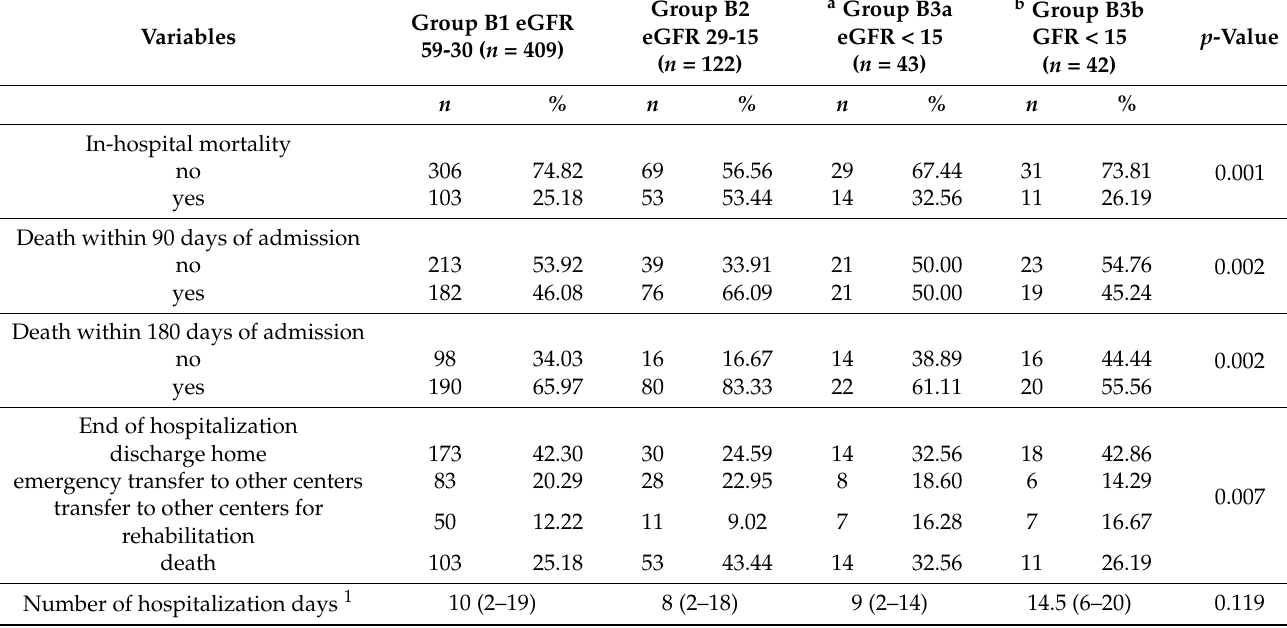
Table 8. Comparison of outcomes between subgroups of group B (eGFR < 60 mL/min/1.73 m 2 ).